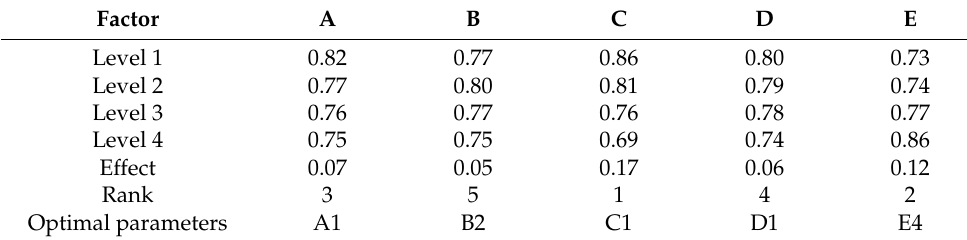
Table 16. Multiobjective Response Form.